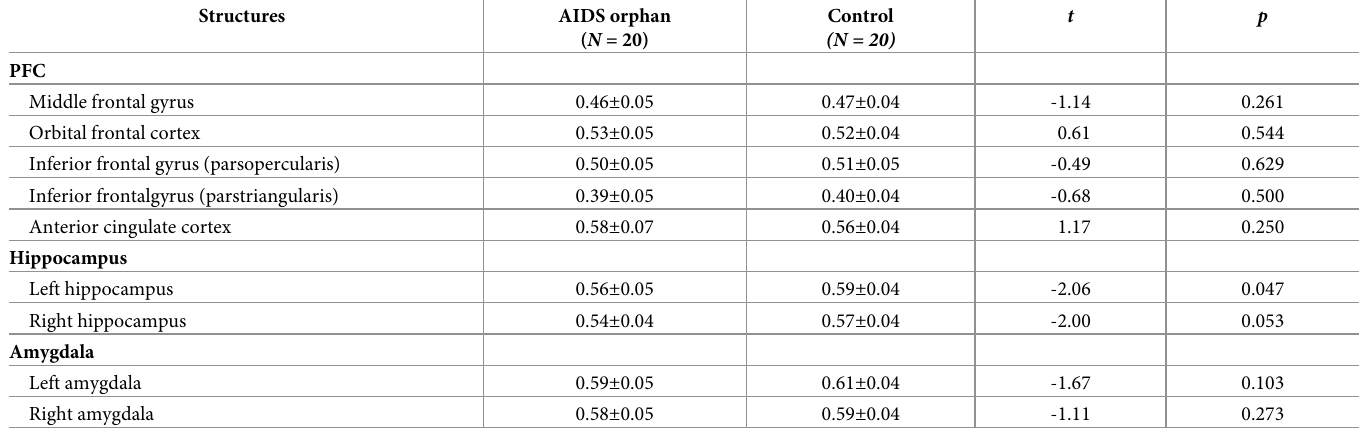
(Table 1). After the control for age, sex, and total gray-matter volume, AIDS orphans and Table 1. Mean values and standard deviation for region sizes for the PFC, hippocampus and amygdala.